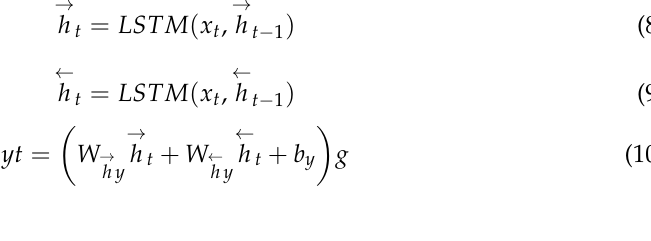
Table 1. Network structure